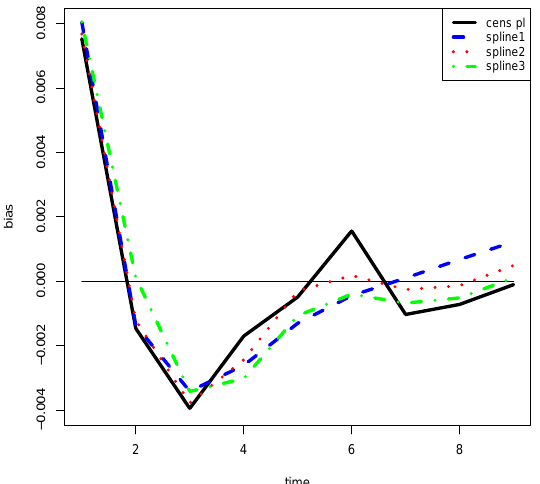
Figure 4. Bias for each of the three splines of “cens pl” estimator.